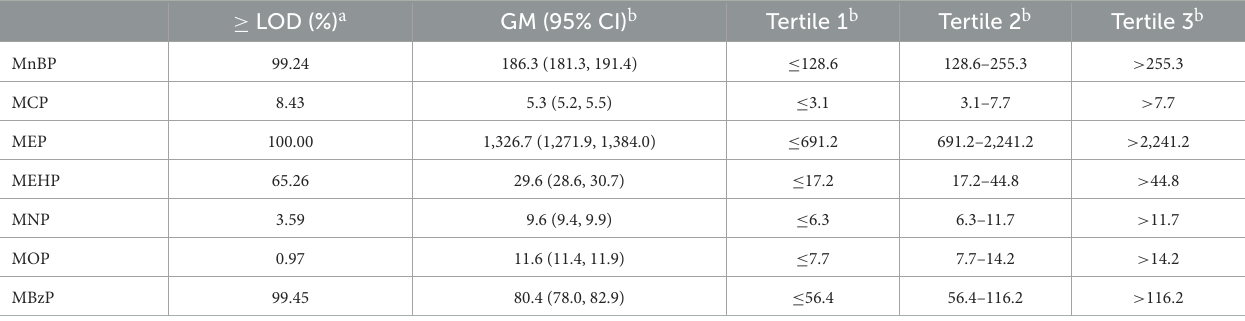
TABLE 2 Distribution of urinary phthalates levels ( µ g/g creatinine) in US adults,NHANES 1999–2004.